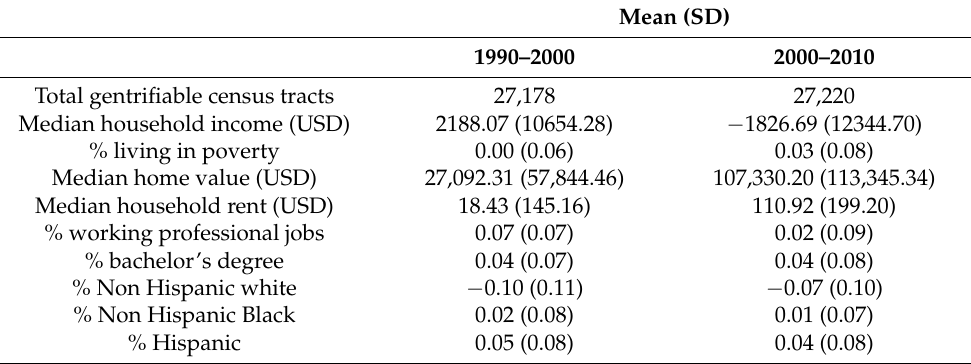
Table 1. Mean change in sociodemographic and housing cost variables, 1999–2000 and 2000–2010, across the gentrifiable census